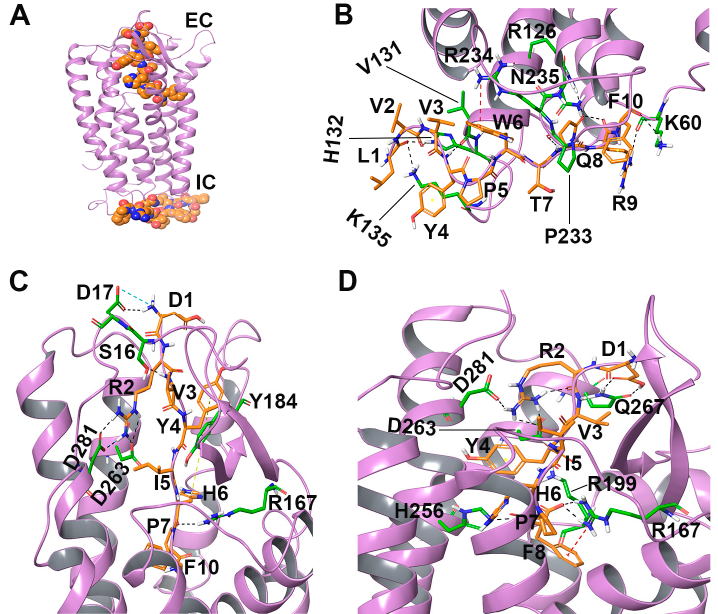
Figure 4. Structure of AT1R with the docked peptides. AT1R structure is shown in purple cartoon representation while its interacting residues are shown in green stick representation. Docked peptides are shown in orange stick representation. Black, yellow, and red dotted lines represent hydrogen bonds, π – π interactions, and π –cation interactions, respectively. ( A ) Structure of AT1R with AngII docked in the orthosteric site and LVV-H7 docked to the intracellular site shown in space-filling representation, ( B ) docked pose of LVV-H7 and the interactions it forms with AT1R, ( C ) docked pose of AngII in the absence of LVV-H7 and the interactions it forms with AT1R, and ( D ) docked pose of AngII in the presence of LVV-H7 and the interactions it forms with AT1R. For clarity, only important interactions are shown in ( D ). The complete list of interactions formed by LVV-H7 and AngII in the absence and presence of LVV-H7 is given in Table 1. Int. J. Mol. Sci. 2020 , 21 , x FOR PEER REVIEW